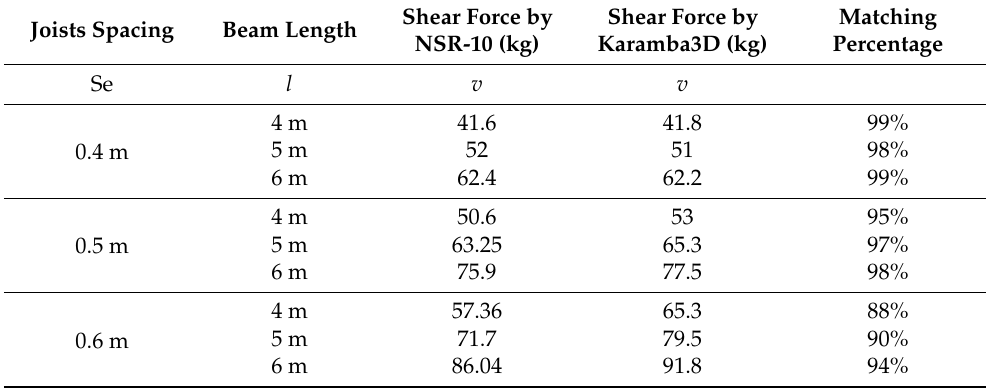
Table 8. Shear force values.